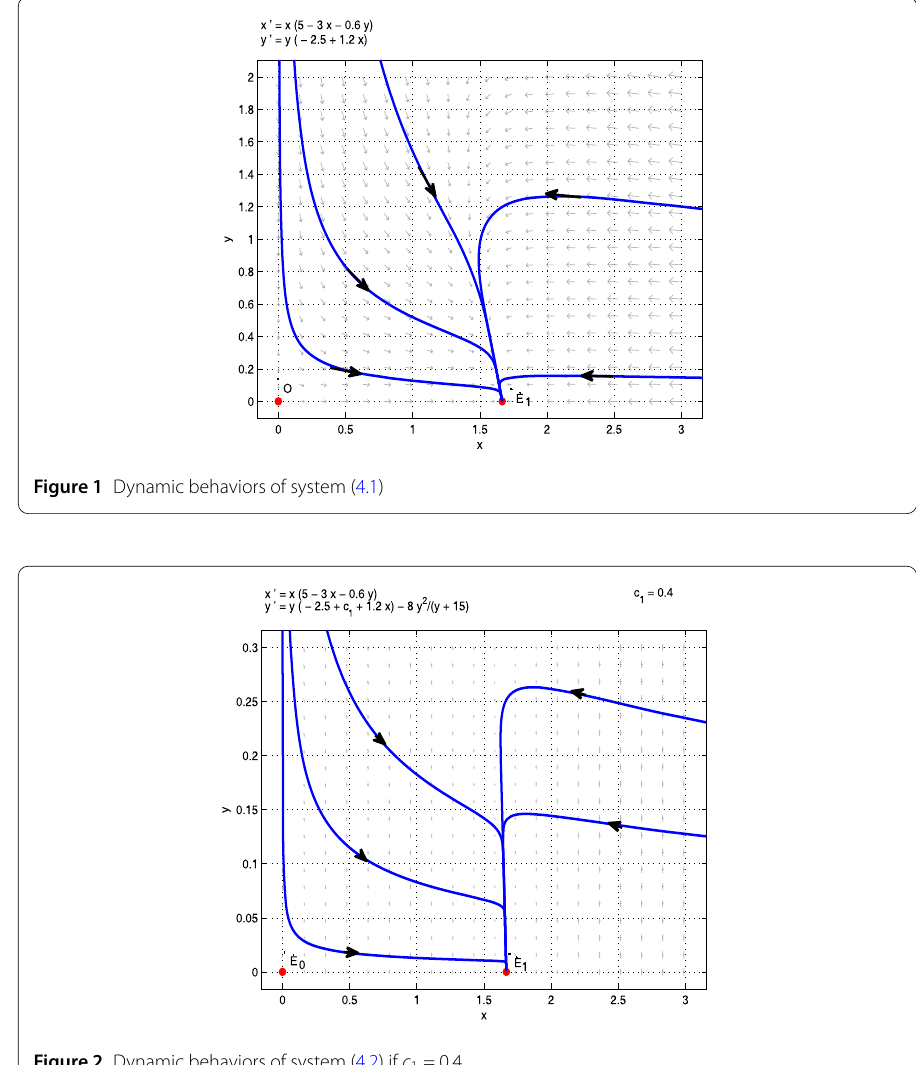
Figure 2 Dynamic behaviors of system (4.2) if c 1 =